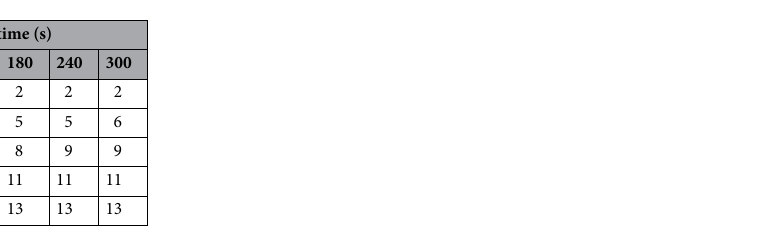
Table 4. The effect of water jet distance (in cm) from the coal face and operating time on hydro-mining effectiveness in terms of the depth of the mined coal face spot.